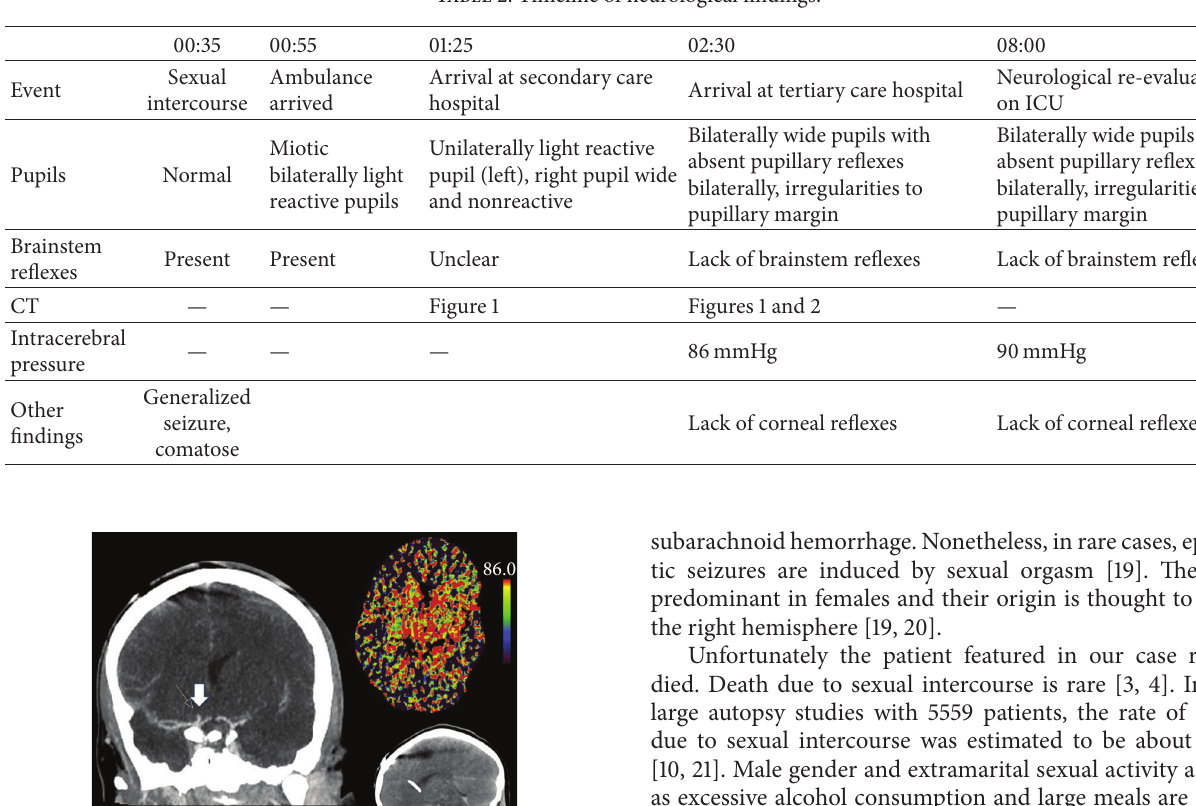
Table 2: Timeline of neurological findings.